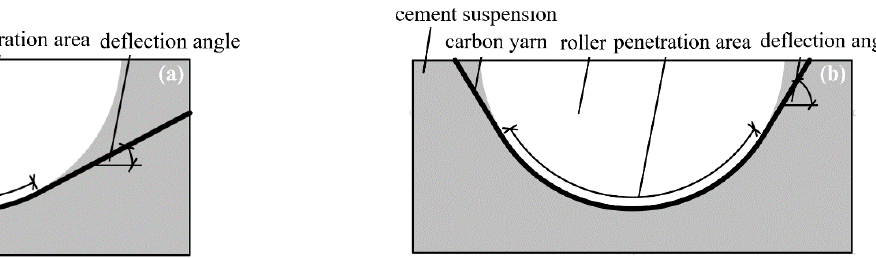
Figure 10. Schematic drawing of ( a ) the low yarn deflection and ( b ) the high yarn deflection through the impregnation roller. Table 5. Yarn pulling forces during processing and mass/length ratios of fresh MCF made with varied yarn deflection: average values, standard deviations in